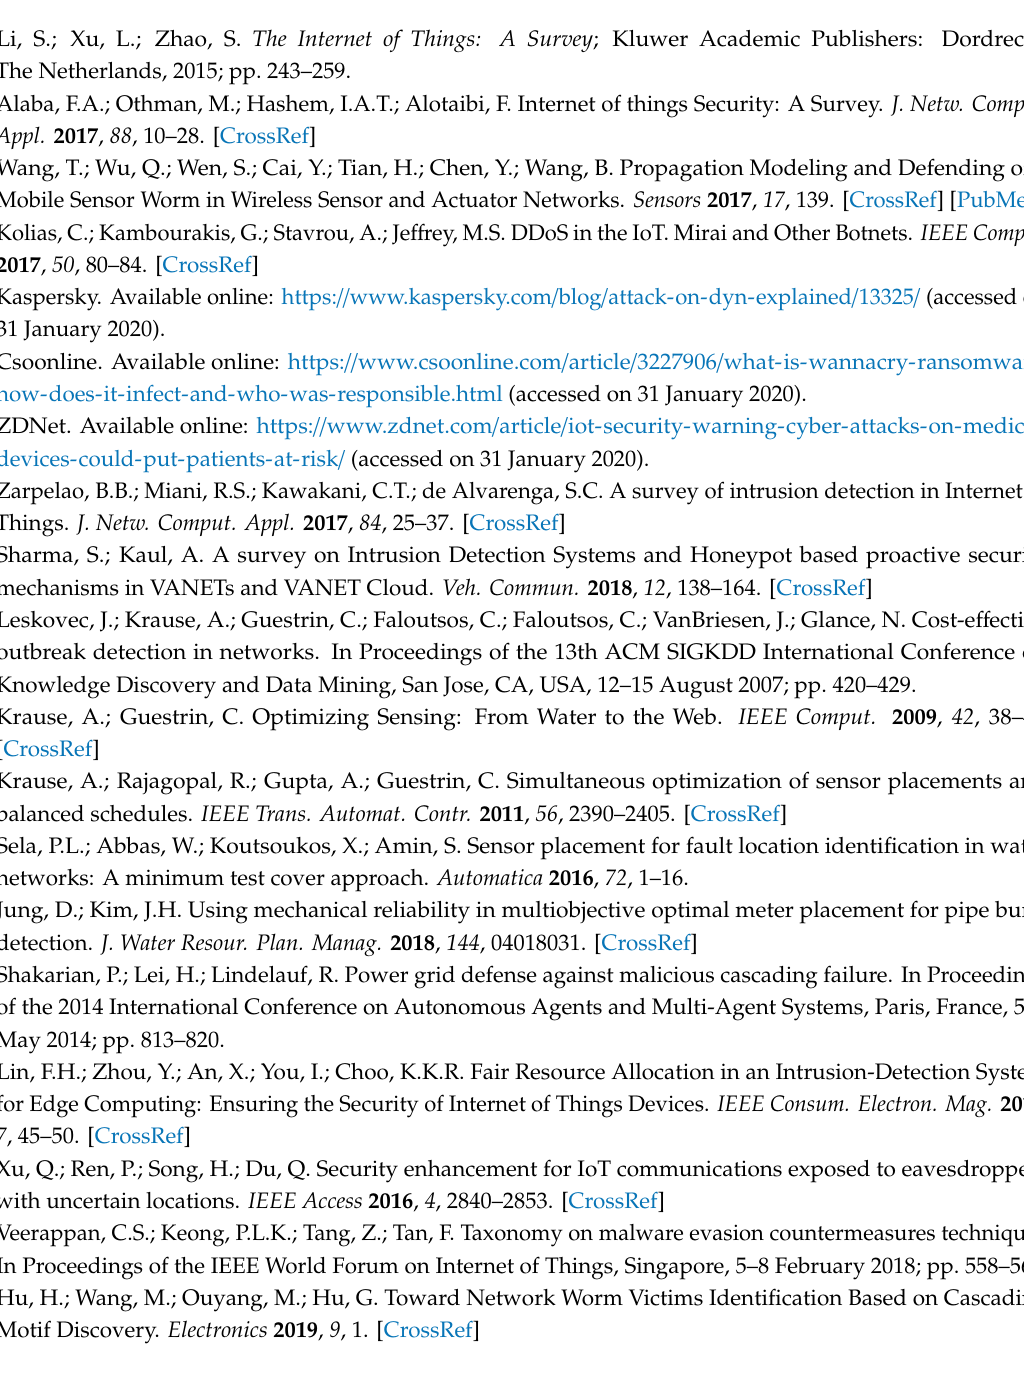
algorithm-greedy algorithm. Finally, we demonstrate the e ff ectiveness, scalability and robustness of our scheme through